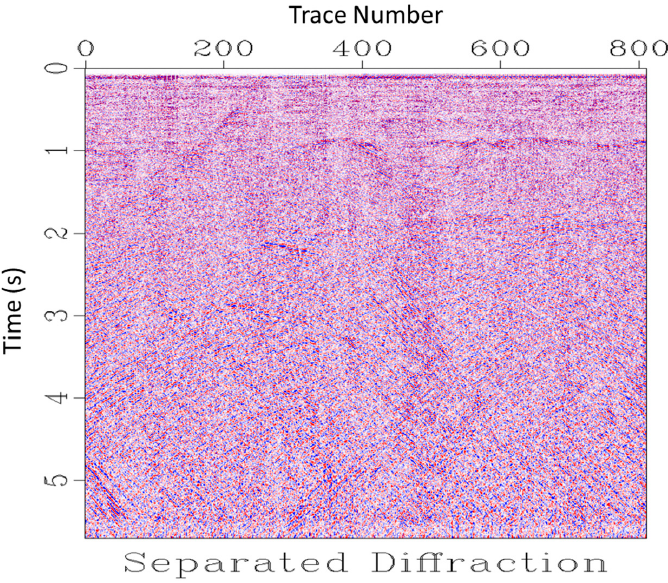
Figure 14. Pre-migrated preserved diffractions following the application of the plane-wave destruction (PWD) filtering on zero-offset data.